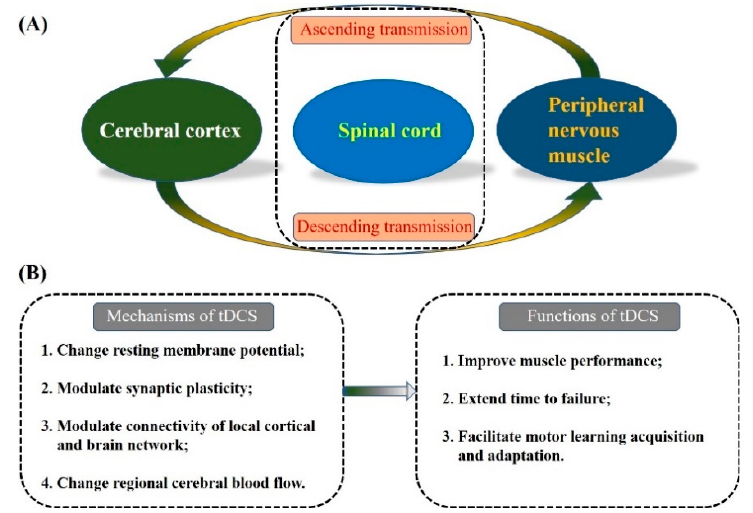
Figure 1. Information pathways between the cortex and the musculoskeletal system ( A ), and the mechanisms and functions of tDCS ( B ).